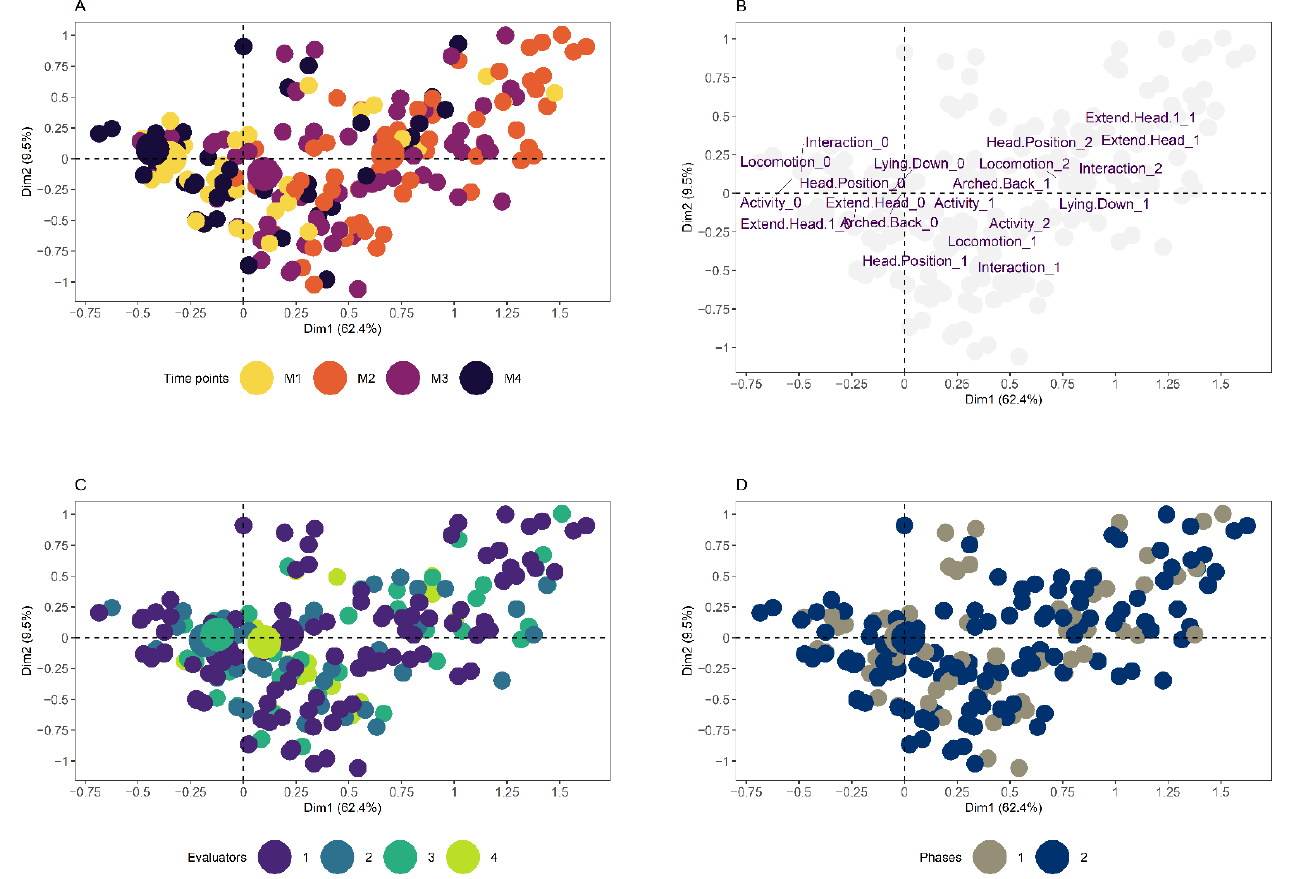
Figure 5. Two-dimensional perceptual map of the multiple correspondence analysis showing the dispersion of the time points ( A ), behavioral items of the USAPS ( B ), evaluators ( C ), and phases ( D ) based on 100% of the sheep dataset [Time points: before laparoscopy (M1), 3–4h after anesthetic recovery, and before postoperative analgesia (M2), 1 h after the administration of postoperative analgesia (M3) and 24 h after laparoscopy (M4); Smaller circles indicate each evaluation and larger circles indicate the centroid)].